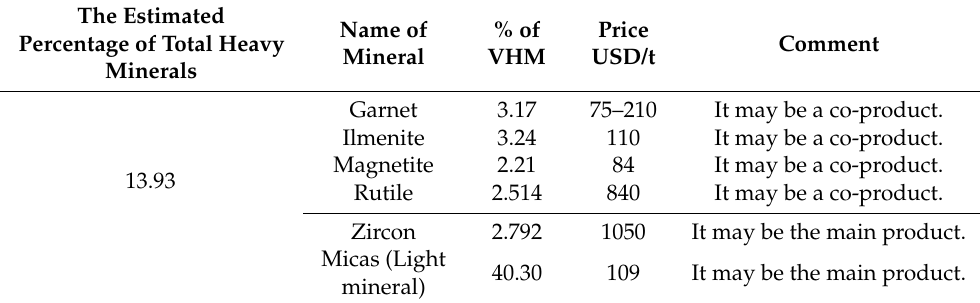
Table 5. Typical prices of the valuable heavy minerals found in the sand of the Hatiya beaches in U.S. dollars. The Estimated Percentage of Total